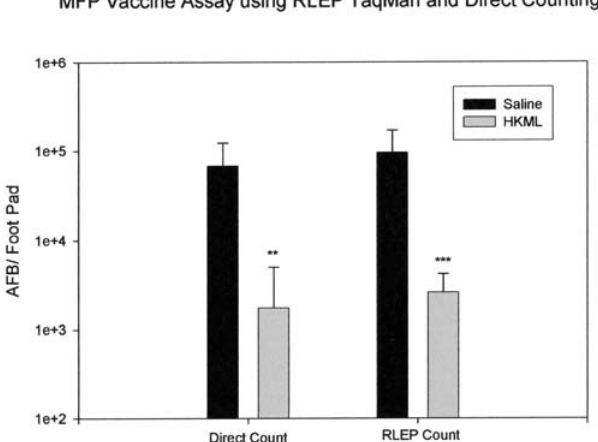
Figure 3. A comparison of RLEP TaqMan PCR and M.leprae counting results from a vaccine trial using conventional C57/B mice. Bars represent mean plus the standard deviation for each group. **=probability of statistical significance (p) , 0.01, and ***=probability of statistical significance (p) , 0.001.